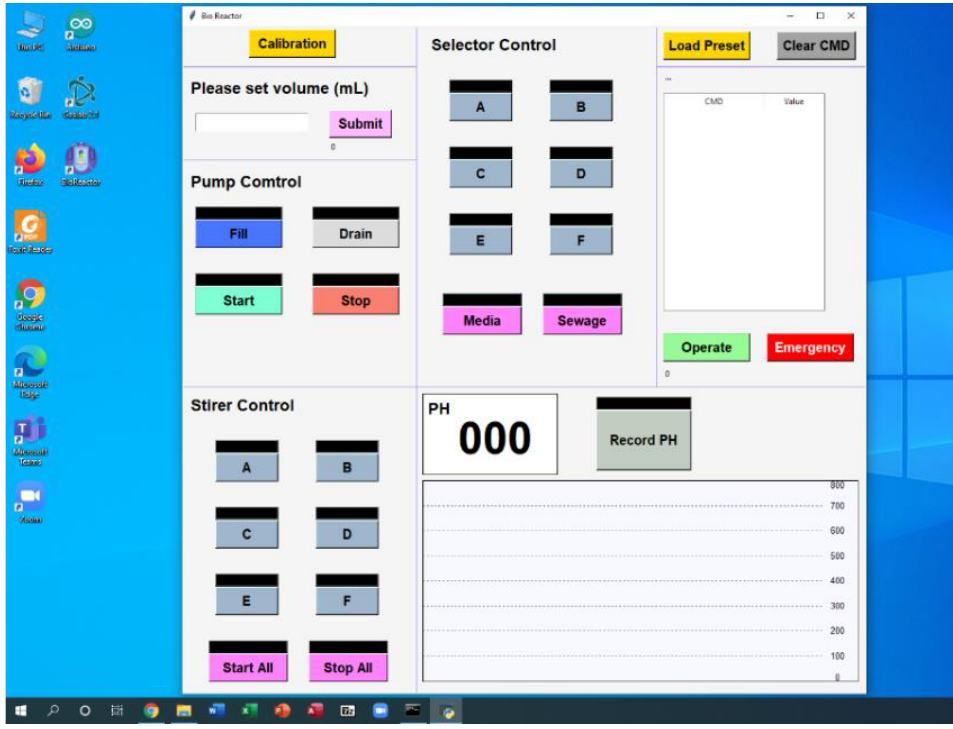
Figure 7. A screenshot of user interface of controlling program.